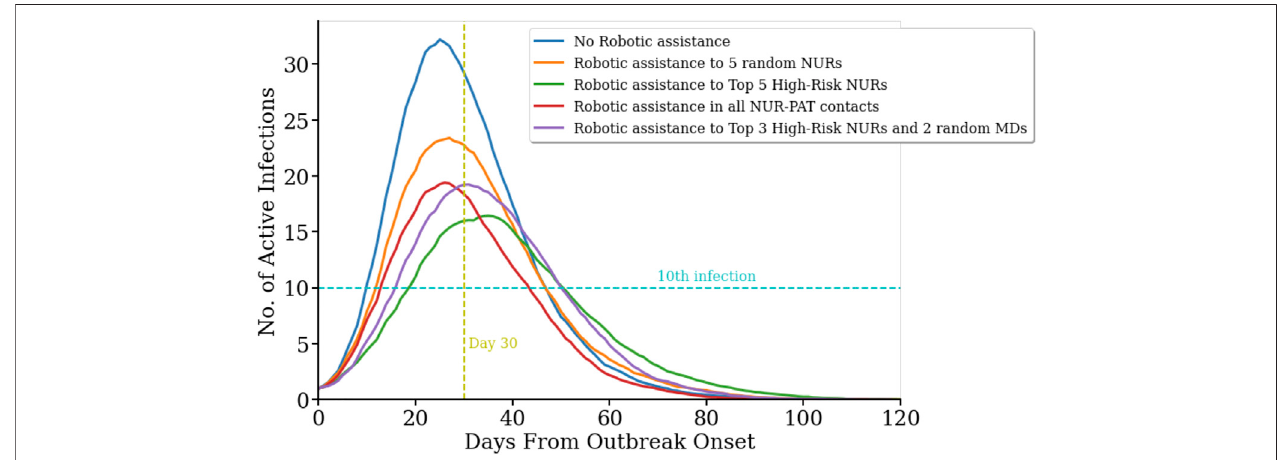
FIGURE2| Temporalevolutionofinfectionspreadacrossthenetworkfordifferencescenarios.(R 0 (cid:1) 4.4).Numberofactiveinfectedcasesin fi vedifferentscenarios as a function of the days passed since the fi rst infection in the population on day zero. No robotic integration (blue line) yields in the fastest onset and highest number of active infected cases. Incontrast,robotic replacementofthe fi venurseswiththehighest number ofcontacts withotherHealth CareWorkers (HCW)and patientsresults in the slowest increaseand the overall lowest number ofactive cases (green line). Replacing fi ve random nurses with robotsleads to more peak active cases and a steeperslope(orangecurve).Replacingallnurse-to-patientcontacts(redline)andthetopthreehigh-risknursesandtworandommedicaldoctors(purpleline)resultedin a similar peak for active cases.